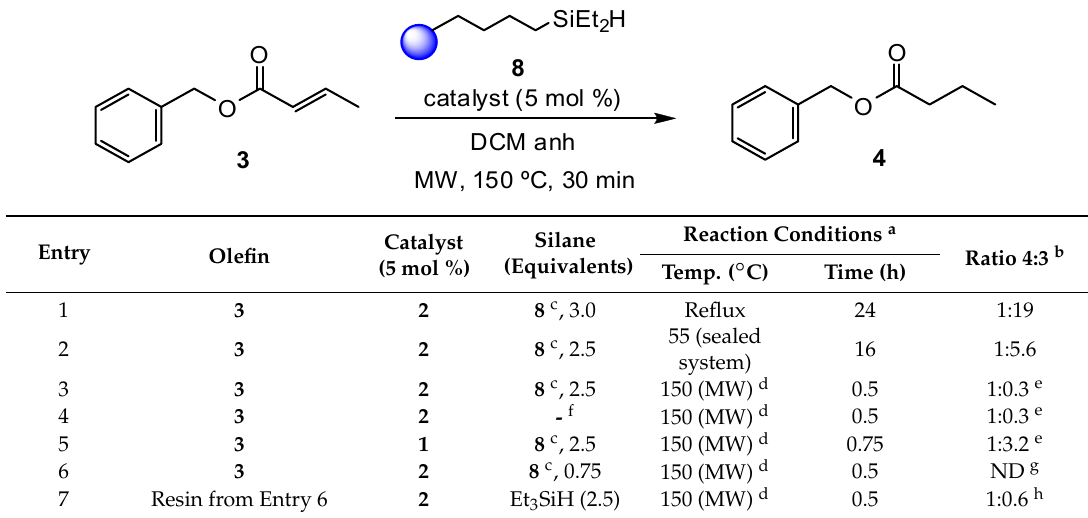
Table 2. Reduction of benzyl trans -crotonate ( 3 ) using resin-immobilized silane ( 8 ) or triethylsilane, in presence of catalyst 1 or 2 .